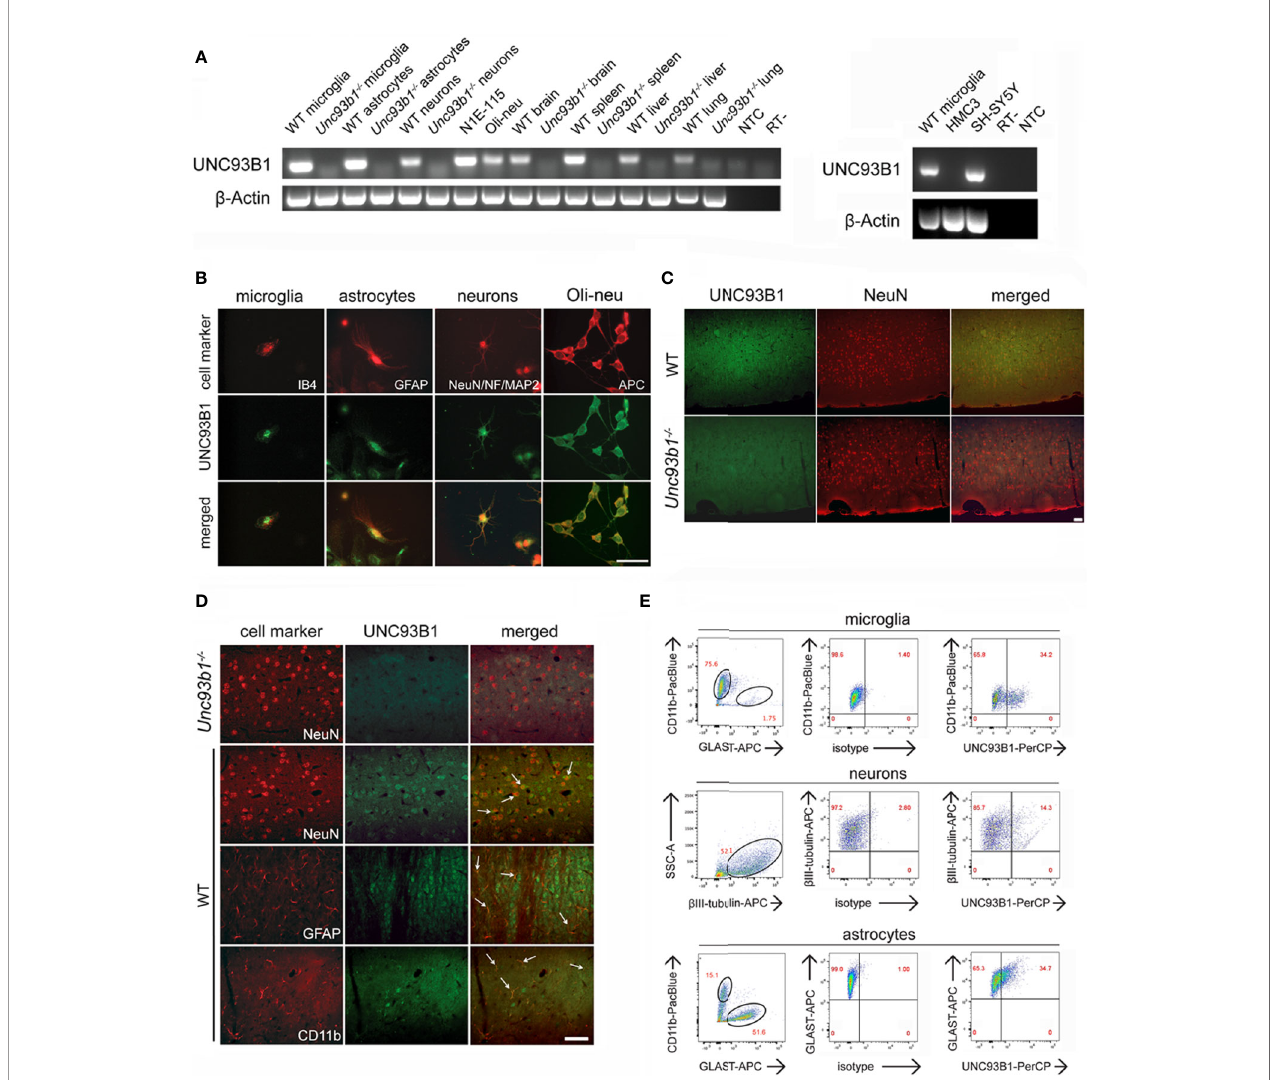
FIGURE 1 | UNC93B1 is expressed in various CNS cell types. (A) Total RNA was extracted from puri fi ed cortical neurons, astrocytes, and microglia, as well as from whole brain, spleen, liver, and lung, derived from C57BL/6 (wild-type, WT) and Unc93b1 -/- mice. In addition, RNA from N1E-115 cells, Oli-neu cells (left panel), as well as human-derived HMC3 and SH-SY5Y cells (right panel) was isolated. Samples were analyzed by RT-PCR, using primers for Unc93b1 . b -actin served as loading control. NTC, non-template control; RT-, condition without reverse transcriptase. (B) Puri fi ed WT cortical neurons, microglia, and astrocytes were immunolabeled with an antibody directed against the C-terminus of UNC93B1 (anti-UNC93B1-C) and co-stained with IB4 to mark microglia, with GFAP antibody to mark astrocytes, and with MAP-2, NeuN, and neuro fi lament (NF) antibodies to label neurons. Oli-neu cells were immunolabeled with the UNC93B1-C antibody and the oligodendrocyte marker APC. Scale bar, 50 µm. (C, D) Brain sections from WT and Unc93b1 -/- mice were immunolabeled using antibodies directed against UNC93B1-C, NeuN, GFAP, and CD11b, the latter serving as markers for neurons, astrocytes, and microglia/brain macrophages, respectively. An overview (C) and higher magni fi cation images (D) of the cerebral cortex displaying the respective CNS cell populations are shown. Arrows indicate cells co-labeled with UNC93B1 antibody and the respective cell type marker. Scale bar, 50 µm. (E) WT brain tissue was dissociated, and cells were stained with both anti-UNC93B1-N antibody, recognizing the N-terminal region of UNC93B1, and different surface markers, as indicated. Microglia were de fi ned as CD11b + GLAST - , astrocytes as CD11b - GLAST + , and neurons as CD11b - CD45 - b III-tubulin + cells. Subsequently, cells were analyzed by fl ow cytometry. One representative experiment out of 3 with similar results is